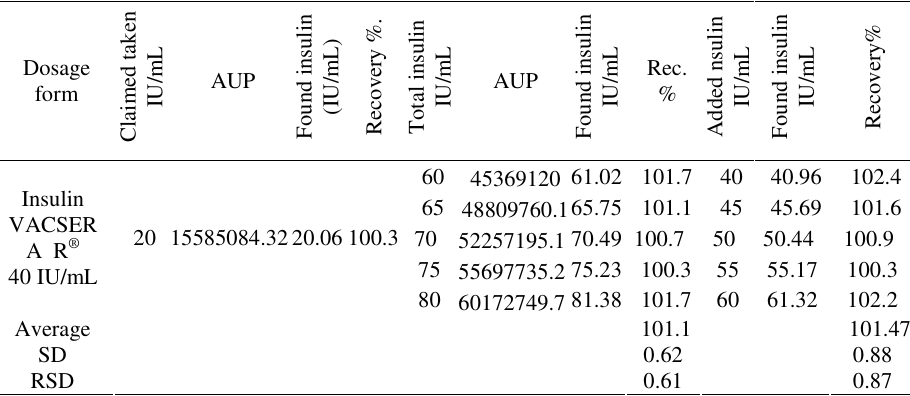
Figure 2. RP-HPLC chromatogram of insulin in vial form. Peaks of phenol, m -cresol and insulin appear at 6.24, 9.36 and 19.15 min, respectively. Table 9. Recovery study of insulin from vial dosage form by applying standard addition technique using the modified RP-HPLC